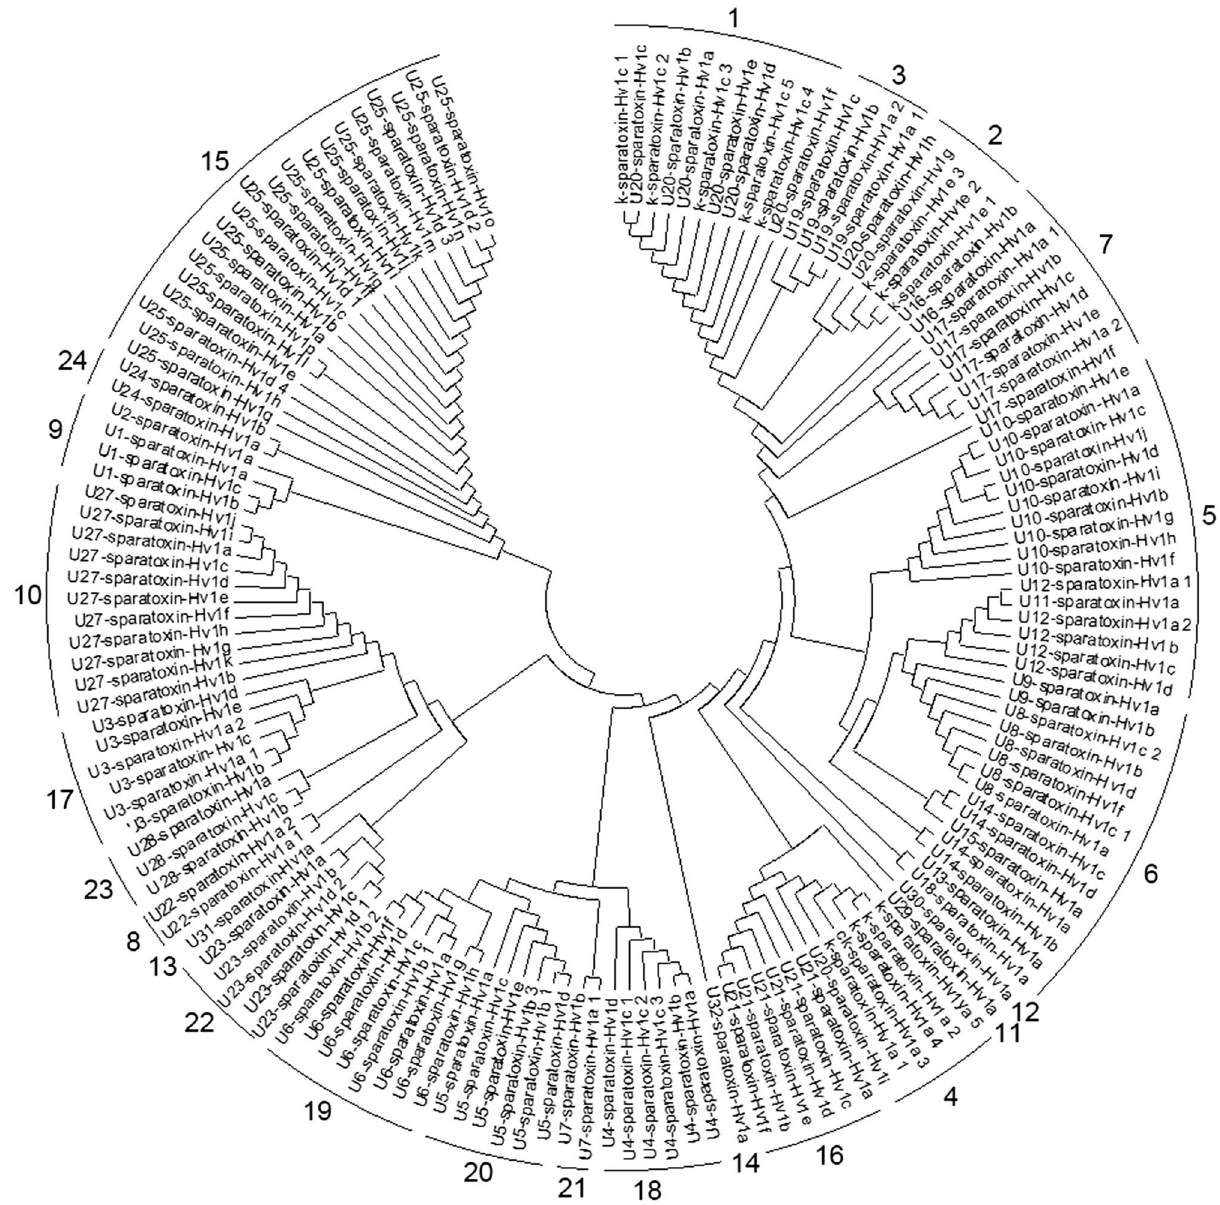
Figure 2. Evolutionary relationships of CRPs from H. venatoria venom glands. The evolutionary history was inferred using the Neighbor-Joining method 33 . The tree is drawn to scale, with branch lengths in the same units as those of the evolutionary distances used to infer the phylogenetic tree. The evolutionary distances were computed using the Poisson correction method 34 and are in the units of the number of amino acid substitutions per site. This analysis involved 151 amino acid sequences. All ambiguous positions were removed for each sequence pair (pairwise deletion option). There were a total of 205 positions in the final dataset. Evolutionary analyses were conducted in MEGA X 35